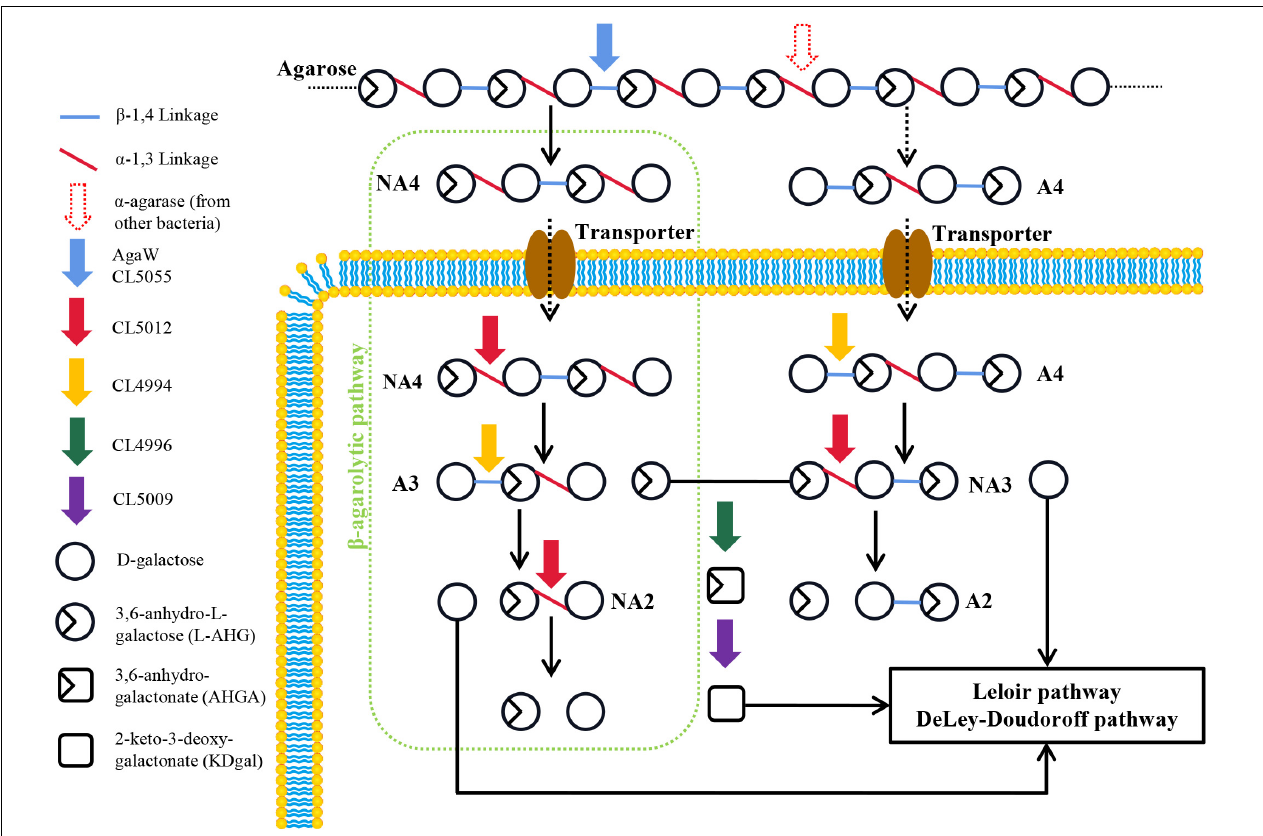
FIGURE 5 | Schematic model of proposed agarolytic pathway in Cohnella sp. LGH. Extracellular β -agarases AgaW and CL5055 hydrolyzed agarose into neoagarotetraose, and meanwhile the α -agarase from other bacteria might hydrolyze agarose into agarotetraose. Two oligosaccharides were transported into cells via putative transporter. The neoagarotetraose was hydrolyzed into D-galactose and L-AHG by the combined actions of α -NAOS hydrolase CL5012 and agarolytic β -galactosidase CL4994. Meanwhile, D-galactose and L-AHG were released from agarotetraose by sequential actions of CL4994 and CL5012. D-galactose was metabolized through Leloir or DD pathway. L-AHG was converted into KDgal by the sequential actions of CL4996 and CL5009, and then KDgal was further metabolized by DD pathway. A2, agarobiose; A3, agarotriose; A4, agarotetraose; NA2, neoagarobiose; NA3, neoagarotriose; NA4,